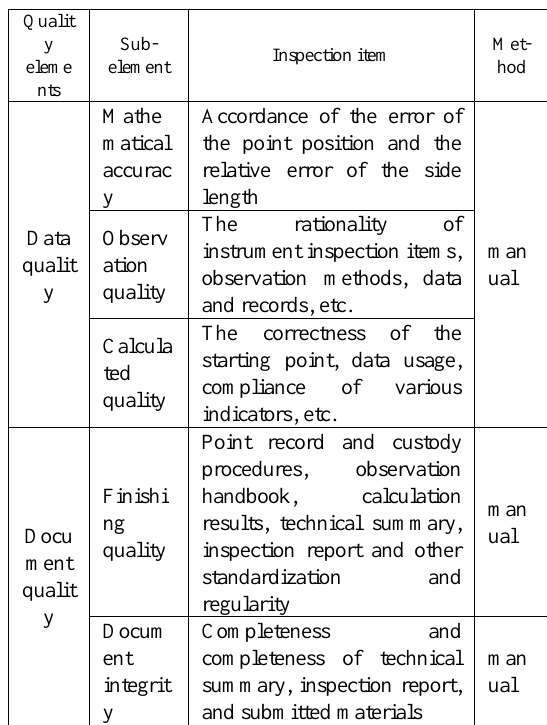
Table 4 . Quality elements in geodetic